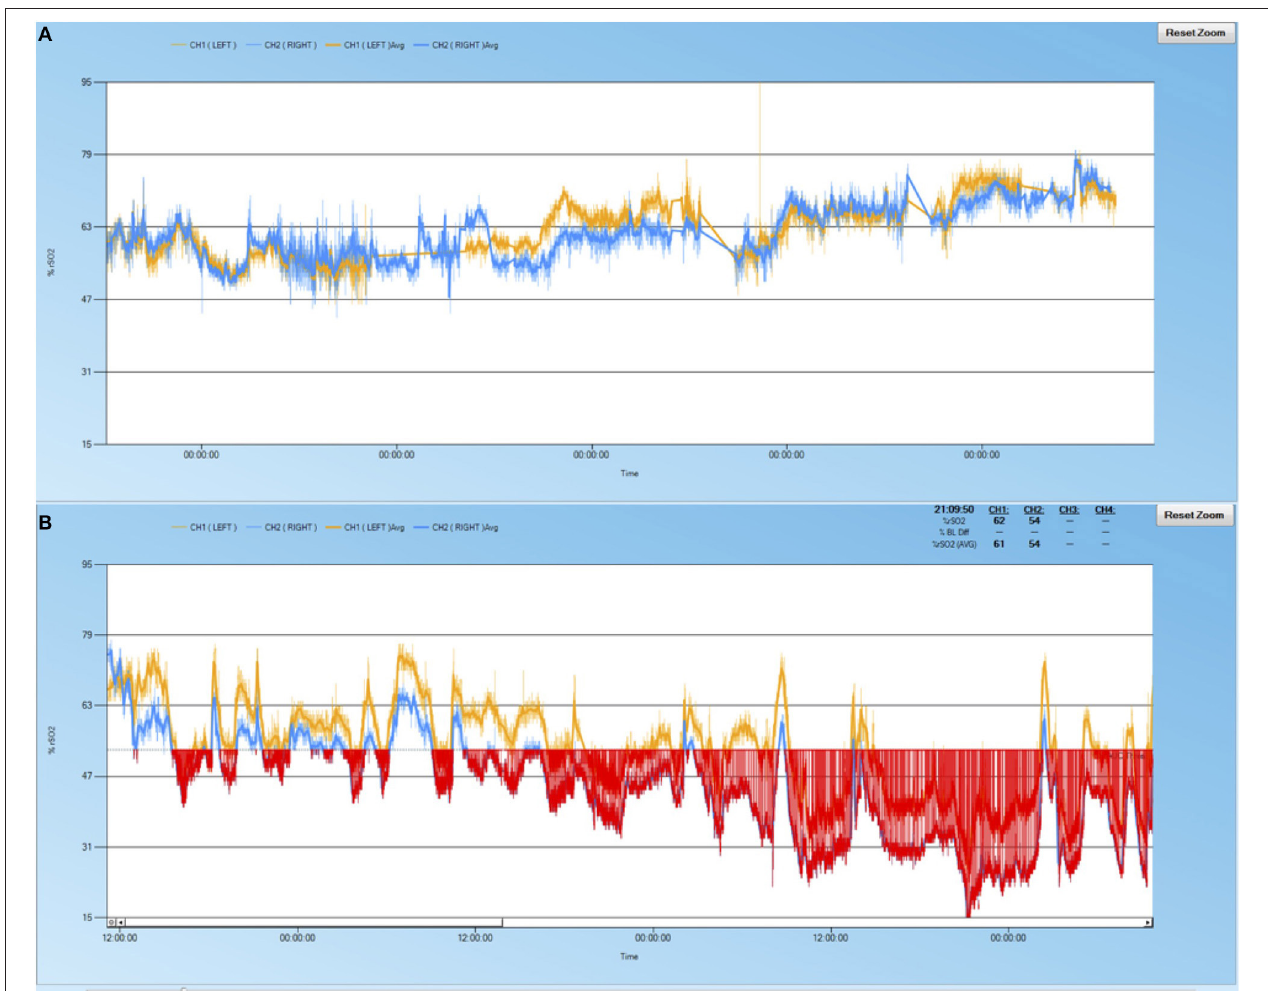
FIGURE 1 | Sample cerebral oximetry time course of patients. (A) 69 year-old male with pulmonary embolus, no acute liver injury, no rScO2 desaturations, normal neuroimaging, and survived to discharge. (B) 64 year-old male with cardiogenic shock, acute liver injury, significant rScO2 burden (red shaded area), watershed infarctions noted on neuroimaging, did not survive to